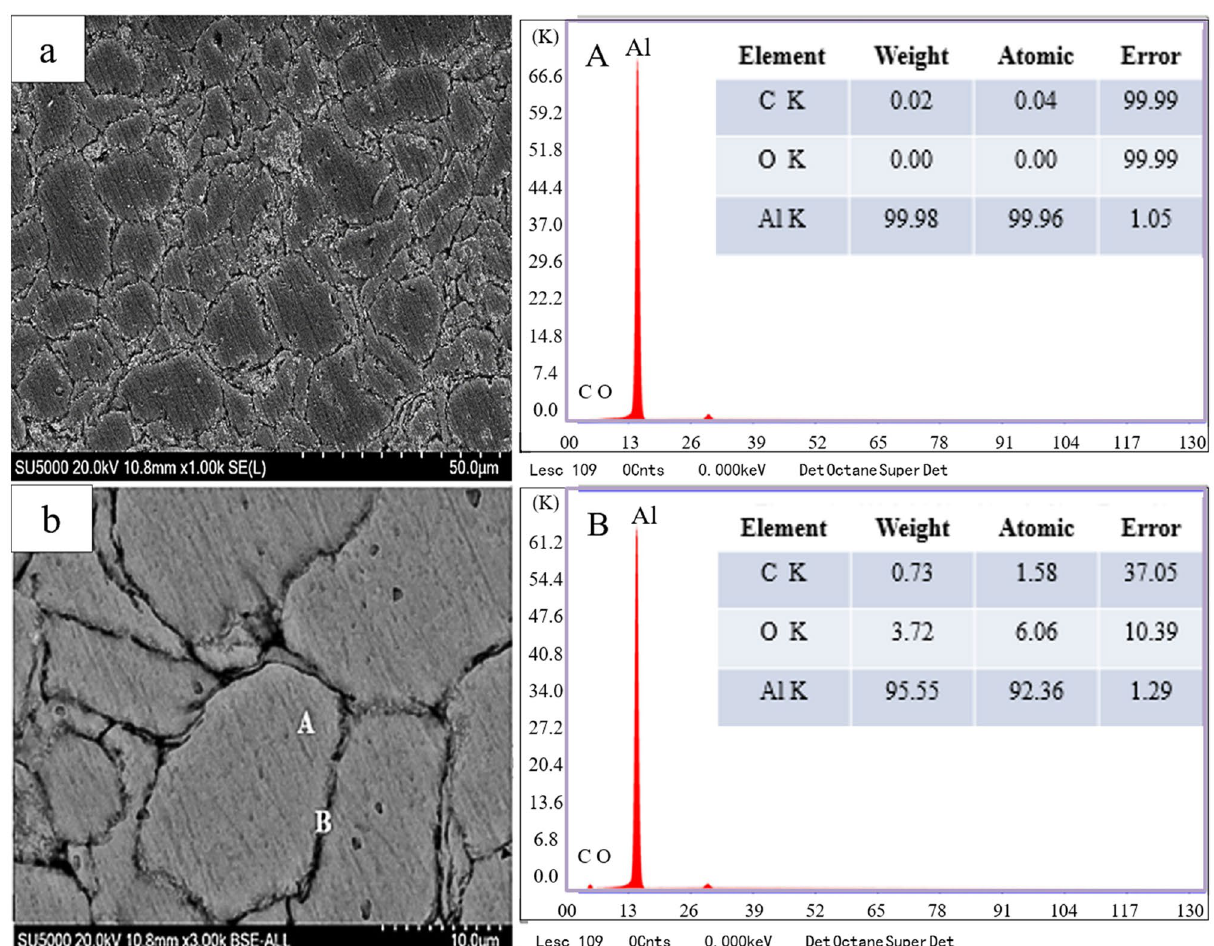
Figure 2. The surface morphology of the prepared GAMCs ( a ) low multiples; ( b ) high